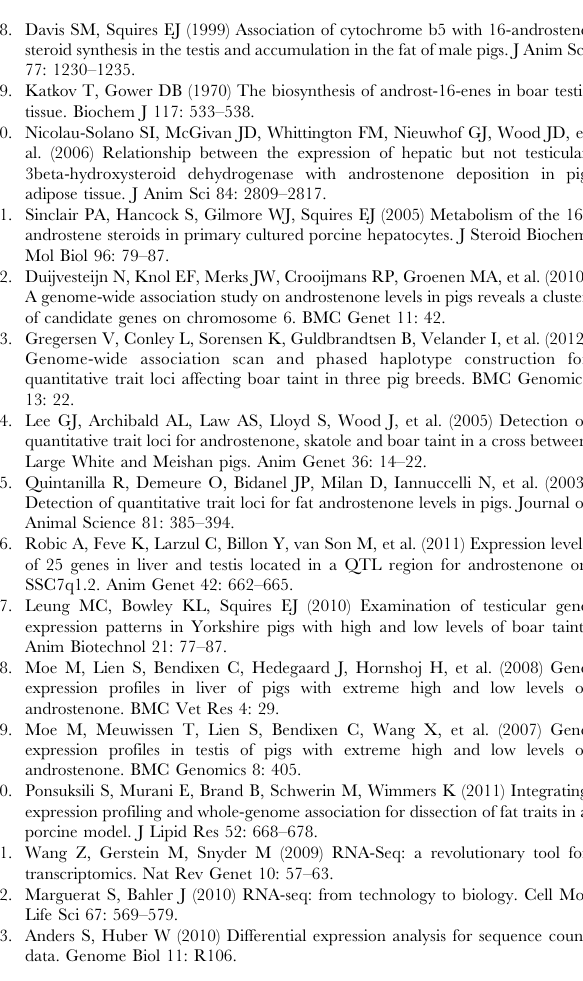
Table S1 GLM analysis results for testis and liver DEGs. Table S2 Sample read counts for polymorphisms on testis and liver DEGs.